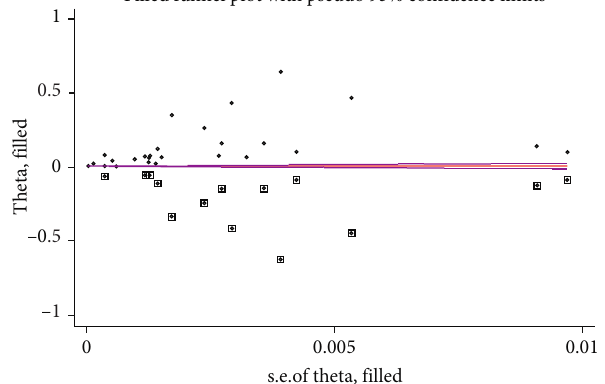
Figure 9: Trim and fill analyses to trim publication bias among studies,